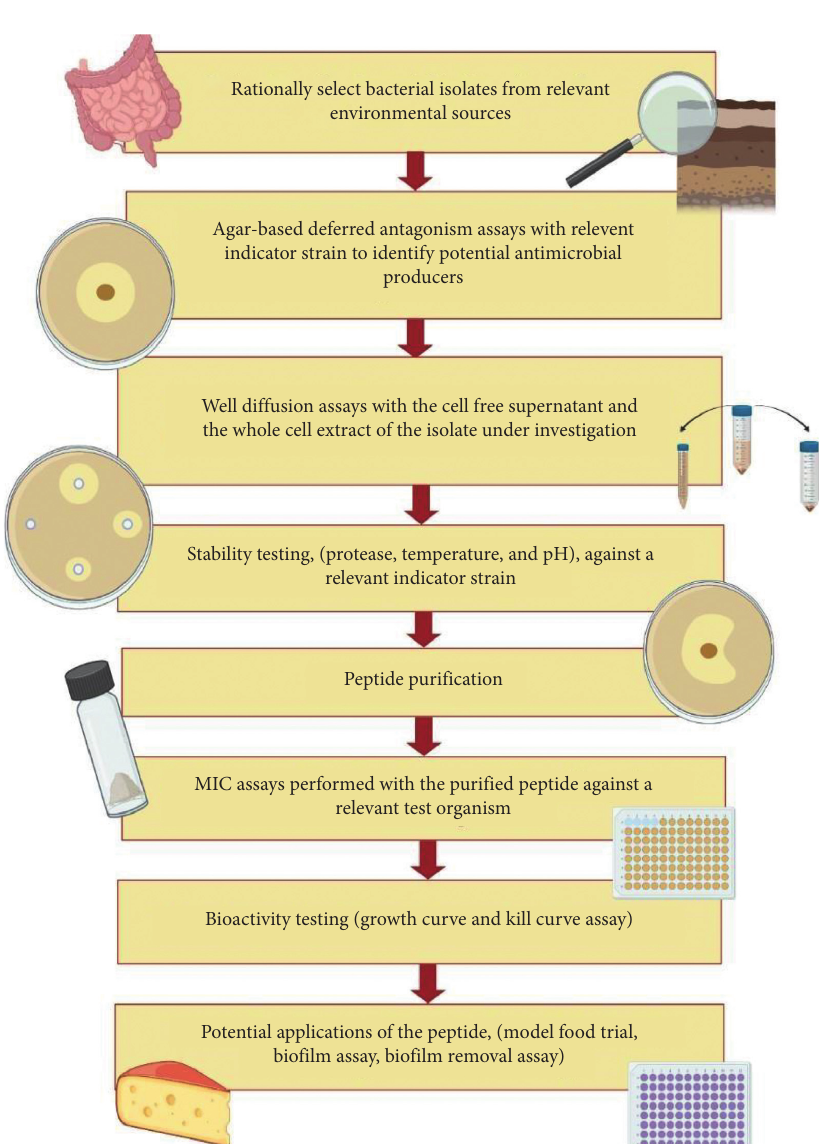
Figure 1: Overview of the approach employed in our laboratory for the isolation and characterisation of bacteriocins. This figure presents the protocols that will be discussed in the following article (e.g., temperature and pH stability studies, growth curves, and model food trials), created in